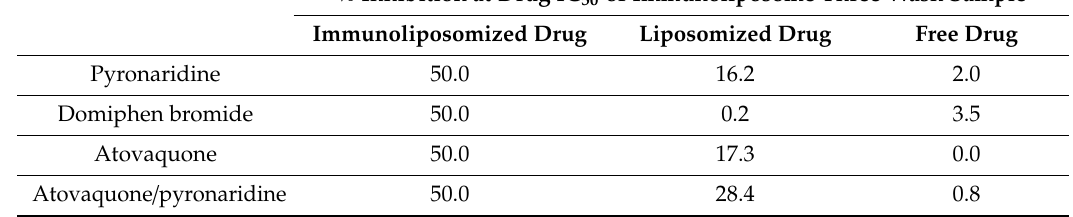
Table 3. Percentages of growth inhibition in in vitro P. falciparum cultures at the corresponding drug concentrations that induce a 50% inhibition in immunoliposomized